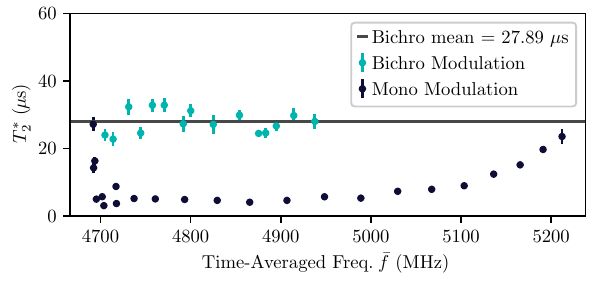
FIG. 4. The T ∗ value of qubit 3 (ref. Table I) as a function 2 ¯ of time-averaged frequency f during different flux modulations. The coherence times in dark blue are measured under monochro- matic modulation at f m = 100 MHz. The coherence times in teal are measured at sweet spots produced by bichromatic modulation of fundamental frequency f m = 100 MHz and different values of mixing angle α and relative phase θ . This figure can be viewed as ¯ values achievable for qubit 3 at a given the best T ∗ f using each 2 resurgence at the single monochro- type of modulation. The T ∗ 2 matic sweet spot is maintainable, with at least the demonstrated operating point density, across a spectrum of bichromatic sweet ¯ FIG. 3. (a) Measured time-averaged frequency of f and T ∗ ¯ 2 spots corresponding to approximately 240 MHz of f flexibility qubit 1 (ref. Table I) during monochromatic and bichromatic for this modulation, plotted as a function of modulation amplitude. This bichromatic modulation is characterized by α/ 2 π = 0.075 and θ/ 2 π = − 0.2. The T ∗ value falls significantly at amplitudes 2 ¯ for which f is flux sensitive, only recovering at points where ∂ ¯ f /∂(cid:2) = 0. Whereas that insensitivity occurs at 0.6 (cid:2) ac 0 in the monochromatic case, this set of bichromatic parameters results ¯ in an equivalent sweet spot at 0.46 (cid:2) 0 , corresponding to an f that is 202 MHz above the protected monochromatic operating point.